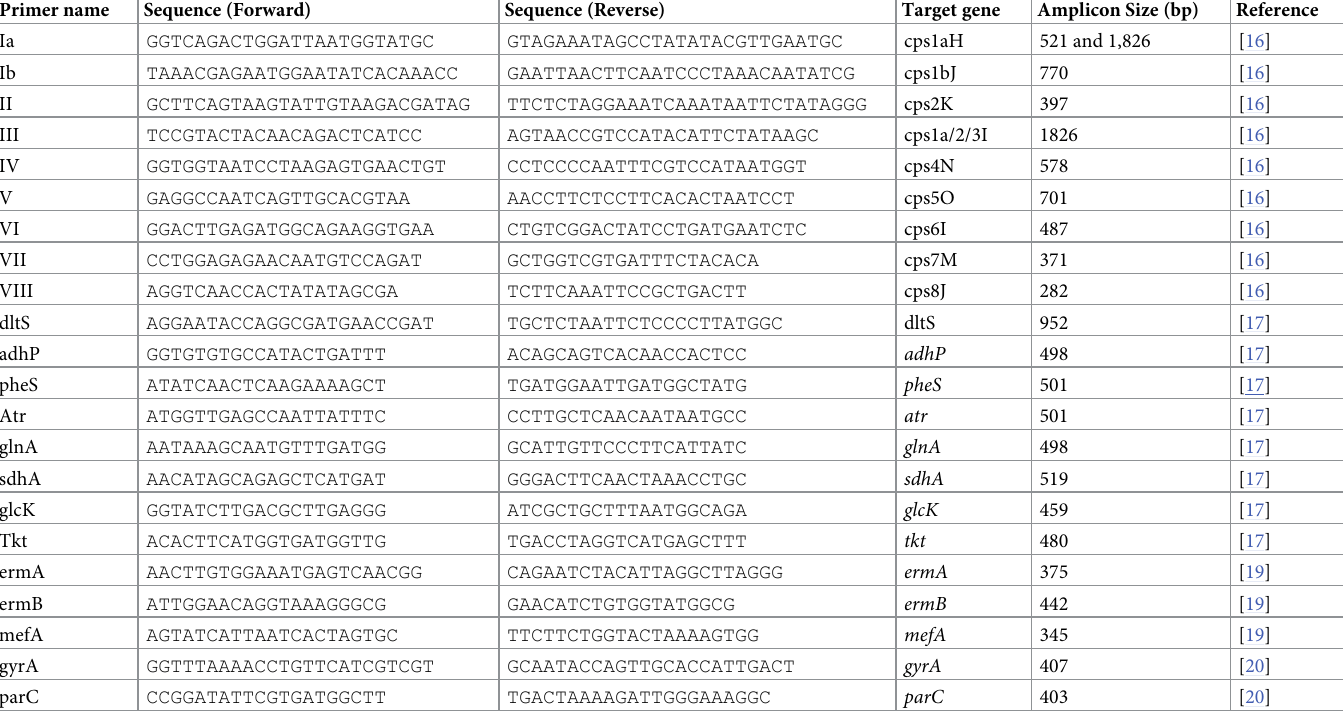
Table 1. Target gene, primer, and probe sequences for GBS molecular serotype determination and antibiotic resistant